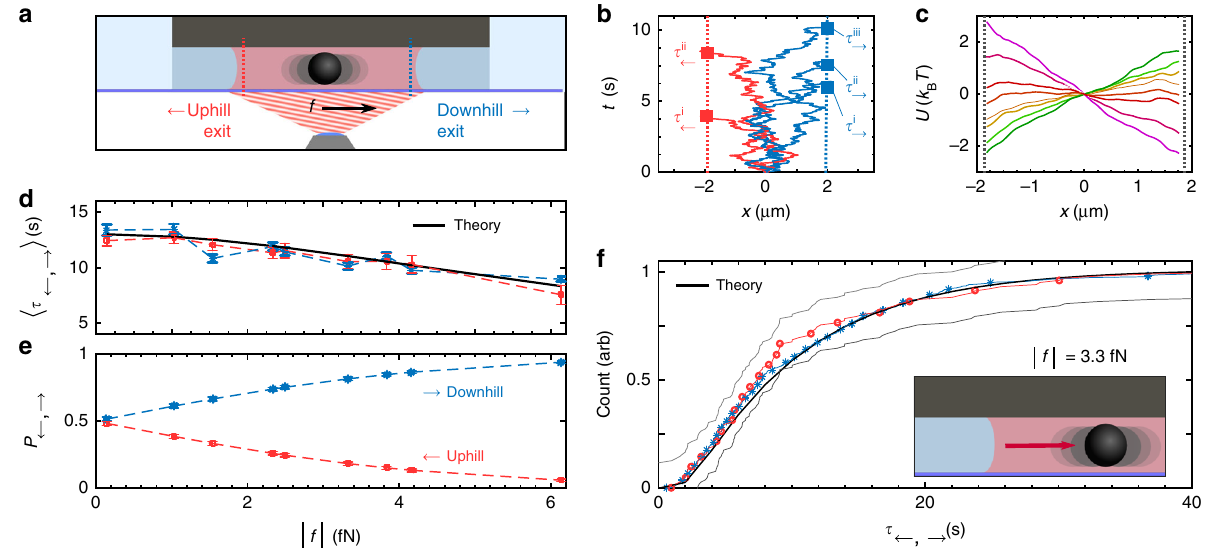
Fig. 2 Exit-path times in the uphill and downhill direction are identically distributed. a Exit-path times of a colloidal particle from a prede fi ned interval (dotted lines) are measured for various phase-gradient forces f ≈ 0 – 6 fN. b Examples of fi ve trajectories and exit-path times. c Inferred potentials (see Methods). The standard error of the mean is given by the line width. The grey dashed lines represent the left and right boundaries of the measurement interval. Each line is either interpreted as uphill or downhill boundary depending on the sign of the force. d Mean exit-path times in the uphill (red) and downhill (blue) directions agree, but decrease with increasing force. Error bars indicate the standard error of the mean. e Probability to exit the interval in the uphill (red) and downhill (blue) direction. Error bars (on the order of the marker size) show the standard error of the mean. f Cumulative distribution of fi rst exit-path times in the uphill (red) and downhill (blue) direction for the 3.3 fN-data point and boundaries of the Kolmogorov – Smirnov test (light grey). The exit times were measured from a prede fi ned interval similar to a (dotted lines). While the lines represent the full data set, the markers only show a selection of the data to avoid crowding of the fi gure. The black line in d and f show Fokker – Planck-based predictions as discussed in the